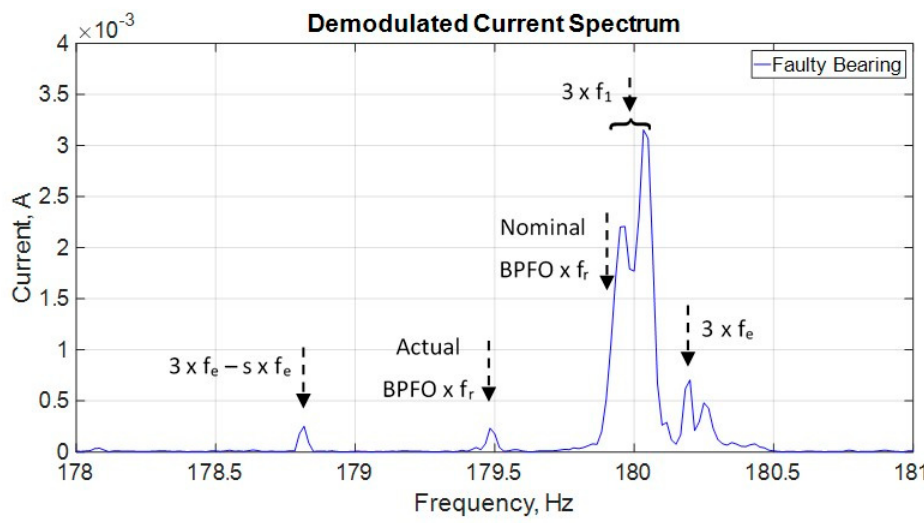
Figure 10. Demodulate current signal spectrum with zoom around the actual BPFO x f r frequency.